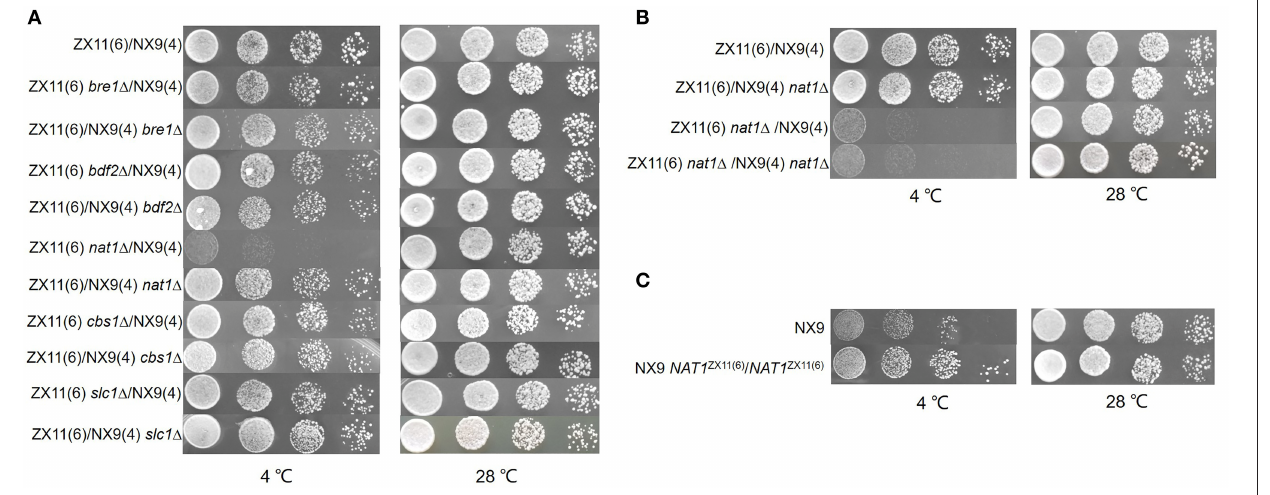
temperature tolerance using reciprocal hemizygosity